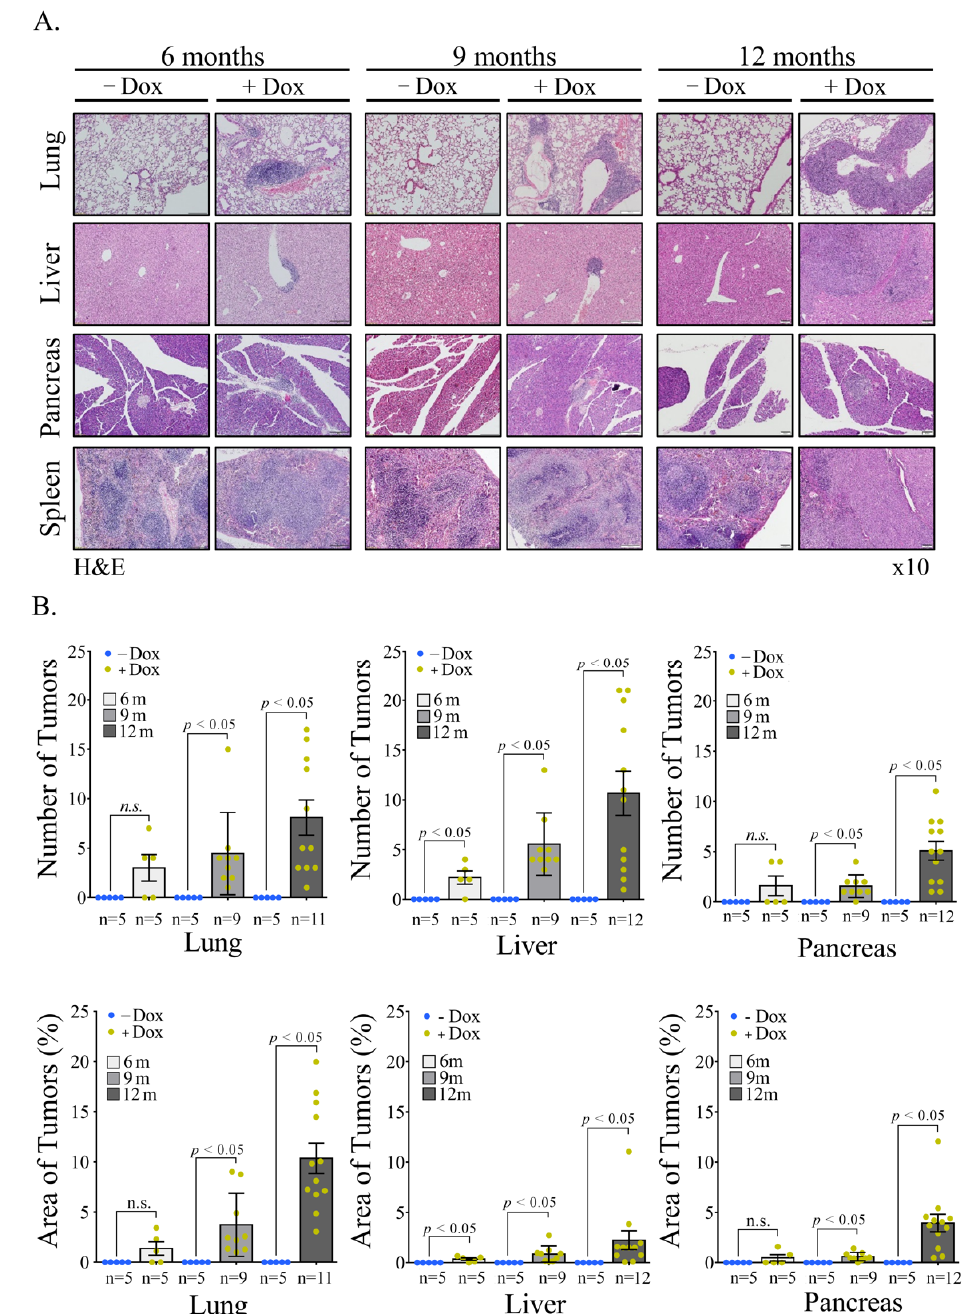
Figure 2. Appearance of Malignant lesions in Rosa Vav1 mice. ( A ) Representative images of hema- toxylin and eosin (H&E) staining of lung, liver, pancreas, and spleen sections from Rosa Vav1 mice either treated (+Dox) or non ‐ treated ( − Dox), at indicated time points after transgene induction. Magnification at × 10. ( B ) Quantitative analysis of tumor numbers (upper panel) and percentage area (lower panel) in H&E ‐ stained sections. The quantitation of area of tumors is detailed in the Material section. Number of mice used: non ‐ treated ( − Dox; 6, 9, 12 months n = 5); treated (+Dox; 6 months n = 5; 9 months n = 9; 12 months n = 12). SEM and significance between the treated (+Dox) and the non ‐ treated ( − Dox) at each time point analyzed by t ‐ test are indicated.